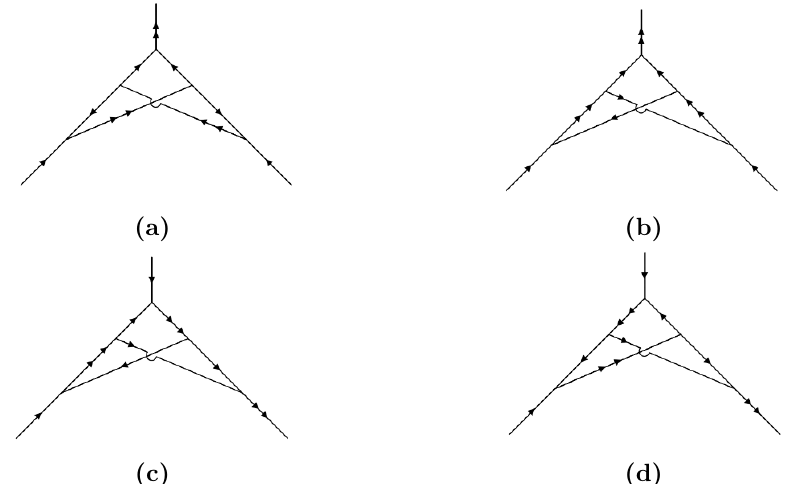
Figure 13. Two-loop 1PI diagram for the three-point vertex. We depicted all the con(cid:12)gurations of arrows associated to the